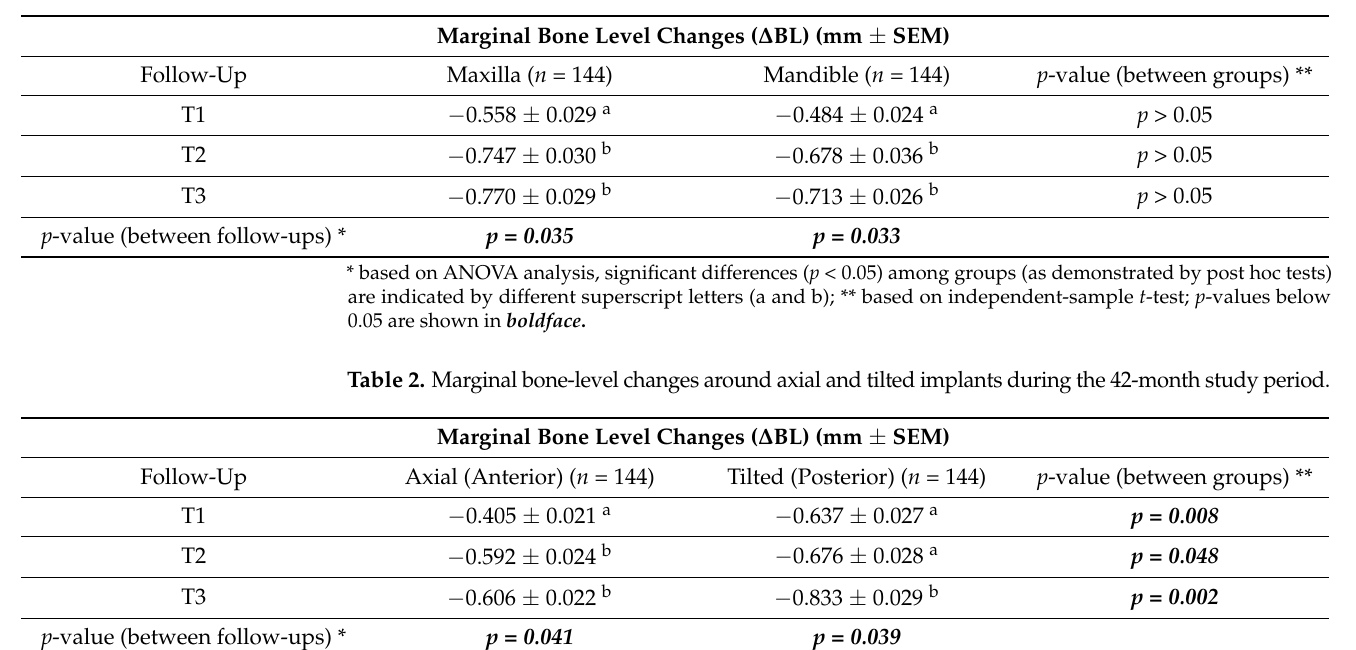
Table 1. Marginal bone-level changes around implants located in the maxilla and mandible during the 42-month study period.